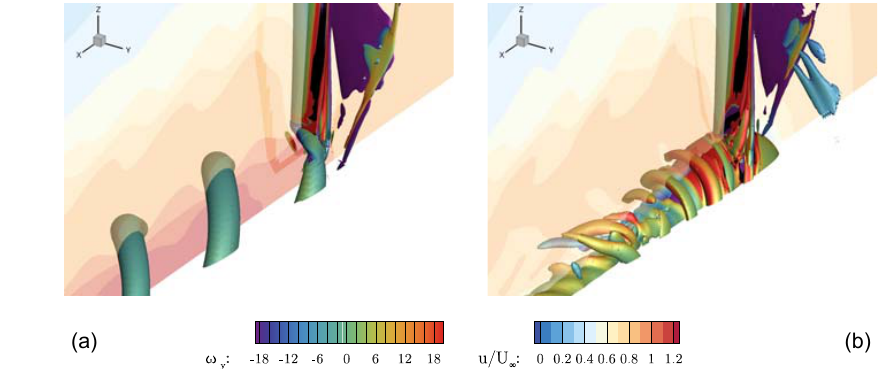
Figure 7. Vortices in the root area visualized by a (cid:51) 2 iso-surface for CaseIsoRotor (a) and CaseT1.0 (b) . The vortices are colored by vorticity in the y direction. The x = 0 slice shows the normalized axial velocity component.